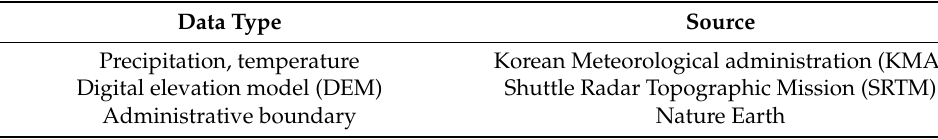
Table 1. Sources of the dataset.